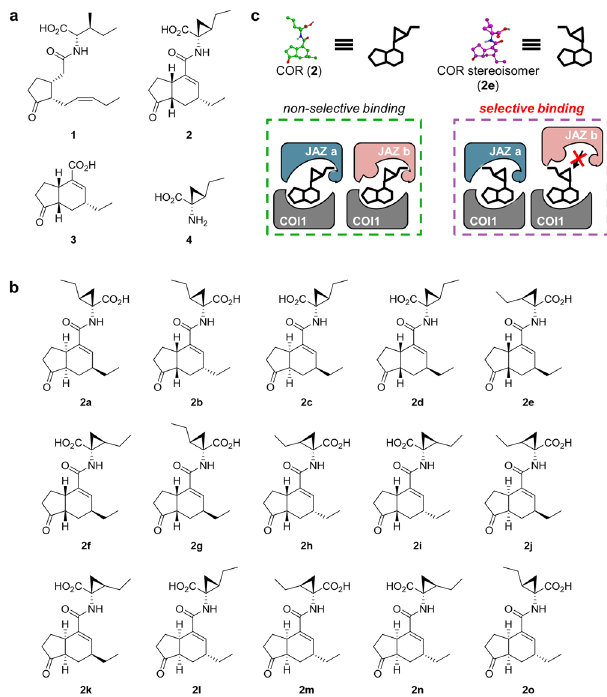
Fig. 1 Chemical library of coronatine stereoisomers. a Chemical structures of JA-Ile ( 1 ), coronatine ( 2 ), coronafacic acid ( 3 ), and coronamic acid ( 4 ). b Chemical structure of stereochemical isomers of 2 ( 2a - 2o ). c Schematic representation of selective binding of 2 -stereoisomer ( 2e ) with COI1-JAZ co-receptors. COR ( 2 ) can interact with most of the COI1-JAZ pairs, whereas the stereoisomer of COR ( 2e ) has a selective af fi nity with some COI1-JAZ